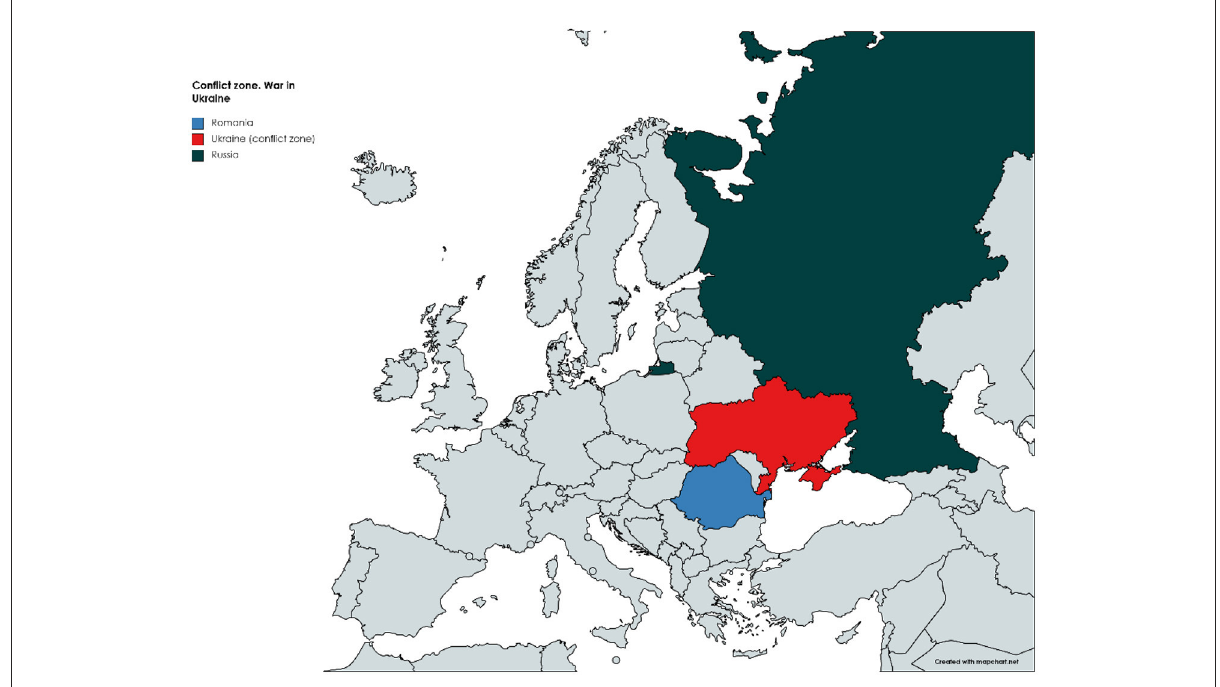
FIGURE1 Conflict zone. War in Ukraine. Source: This map was created on www.mapchart.net.